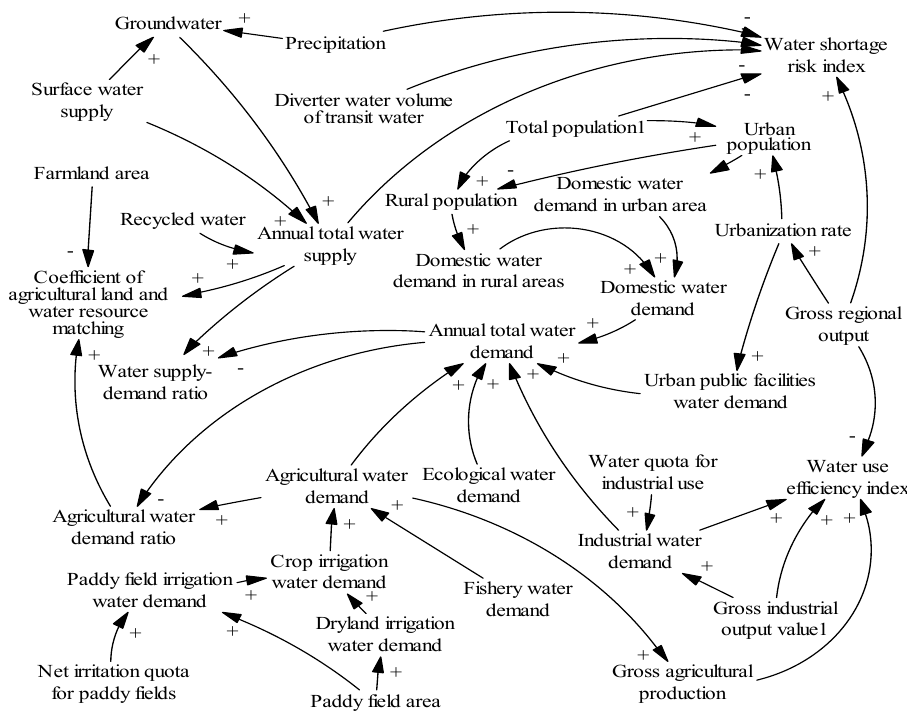
Figure 4. Workflow for the water subsystem.